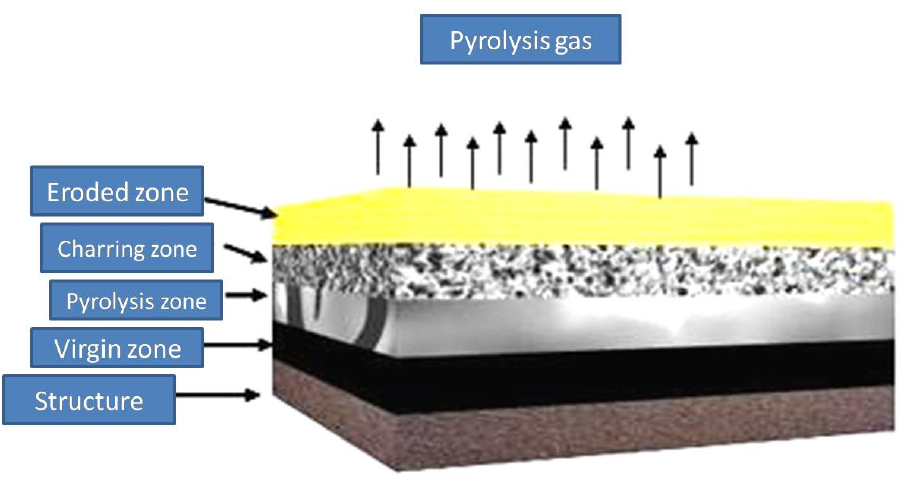
Figure 1. Schematic diagram of the mechanism of ablation of thermosetting